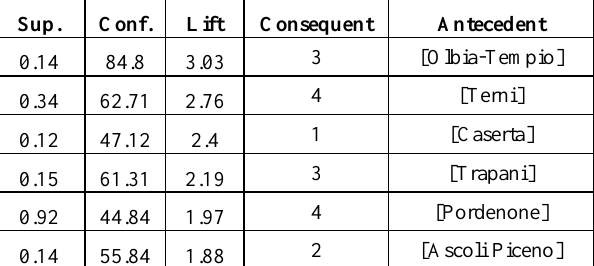
Figure 3. Geographical adminestrative scales: (a) state (b) province (c) commute